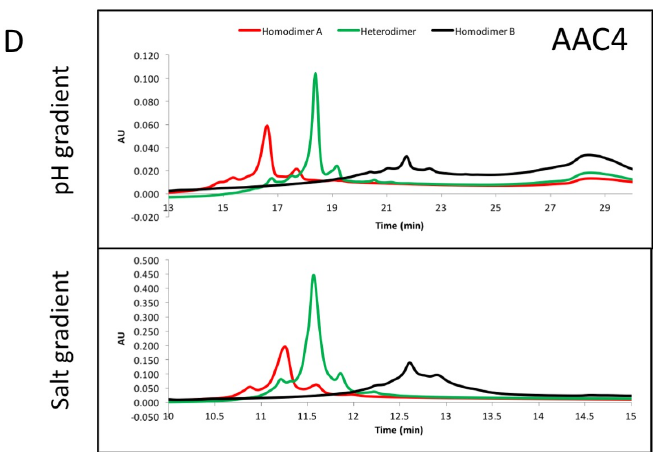
Figure 3. ( A – C ) exemplary results showing the resolution by ion exchange chromatography on an Agilent BioMAb (Weak Cation Exchange) column. The homodimers and heterodimers of asymmetric antibody constructs were independently expressed and purified. ( D ) separation of components using a pH gradient (low pH to high pH, upper panel), or a salt gradient (low salt to high salt, lower panel) using exemplary asymmetric variant AAC4.